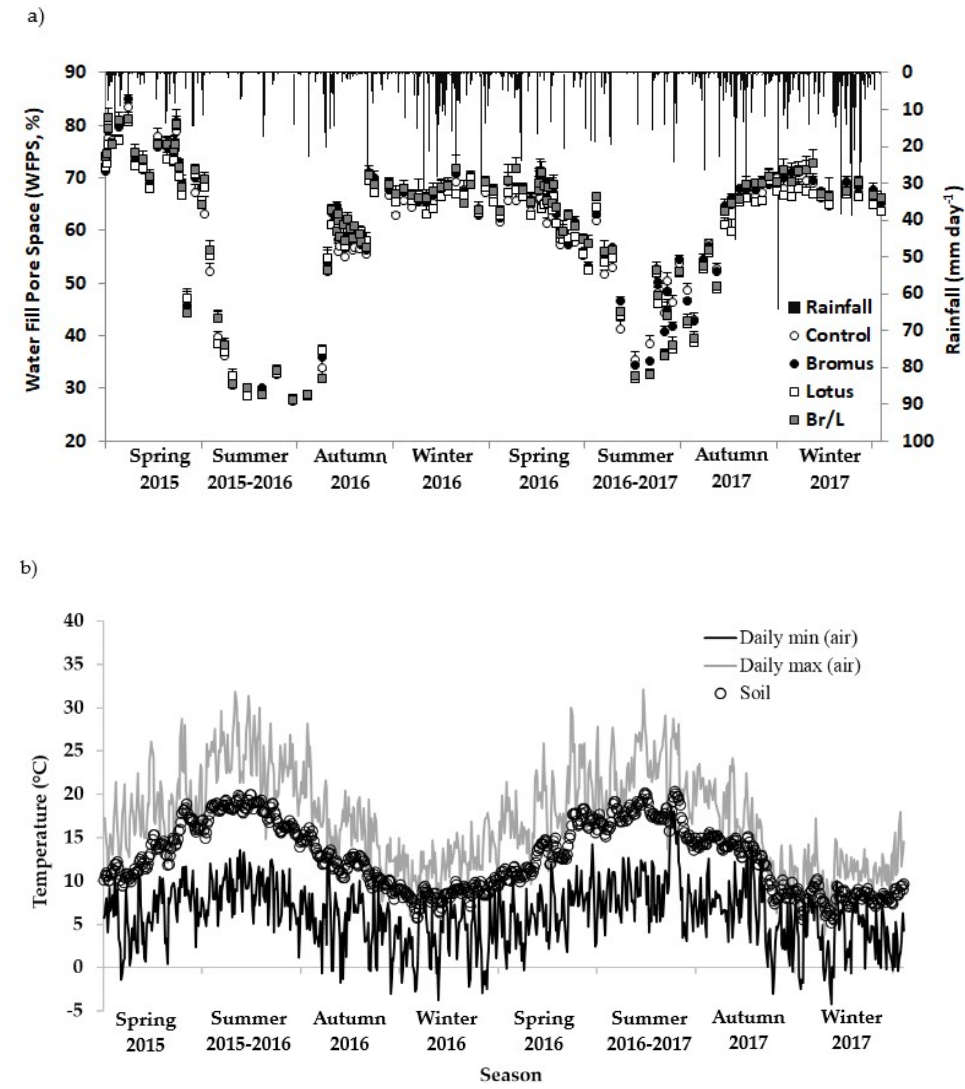
Figure 1. ( a ) Water-filled pore space (WFPS, %) and daily rainfall (mm, inverted in secondary axis), and ( b ) daily air temperature (°C) and average soil temperature (°C, 10 cm depth) during the experimental period. Original data with no interpolation.